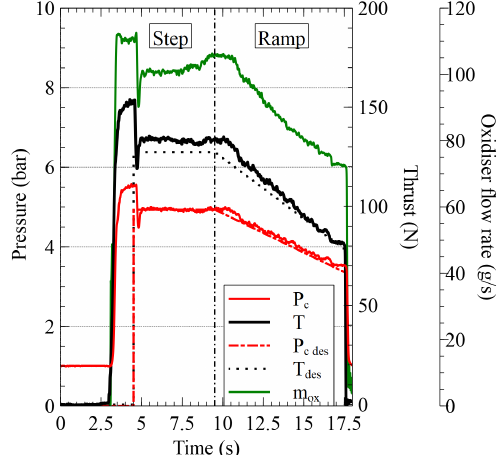
Figure 18. Ramp-down